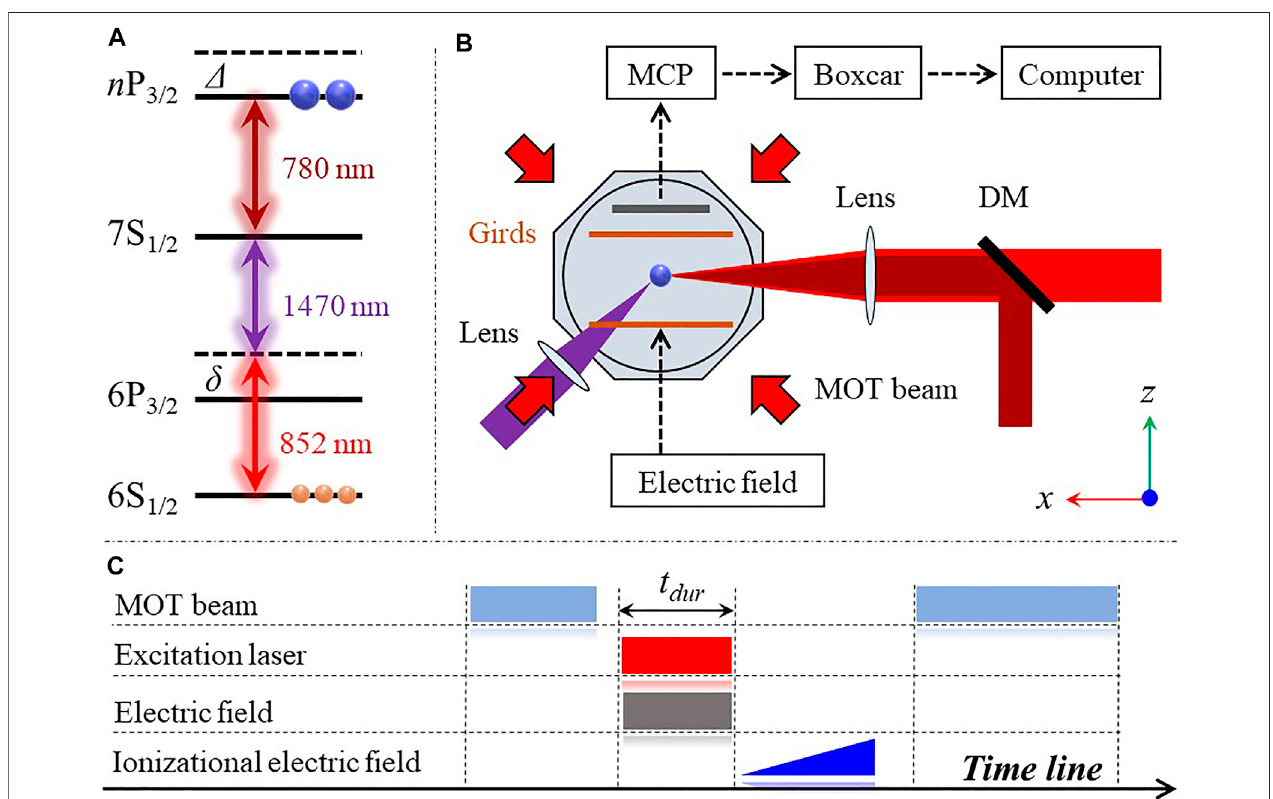
FIGURE2| (color online). (A) Three-photon excitationdiagram ofthe Rydberg state. The fi rst photon from the852 nm (red) laserdrives thelower transition |6S 1/2 〉 → |6P 〉 ,whosefrequencyisbluedetuned δ fromtheintermediatestate.Thesecondphoton,1,470-nm(darkpurple)lasercouplestheintermediatetransitionof|6P 3/2 → |7S 〉 . The third photon, 780-nm (dark red) laser achieves the Rydberg state via the up transition |7S 1/2 Rydbergstateatoms,respectively. (B) Schematicdiagramoftheexperiment.ThreeexcitationlaserscrossthroughtheMOTcenter.TheionsofRydbergatomsare detected with a MCP detector, analyzed with a boxcar, and recorded by a computer. The ramp (DC) electric fi eld is applied to the grids located in the z direction for the fi eld ionization (the manipulation of the Rydberg interaction). Other grids in x − and y − directions are not shown here. (C) Timing sequence. After switching off the MOT beam,theRydbergexcitationpulsewithdurationof6 μ sisswitchedonforpreparingRydbergatoms.DuringtheRydbergexcitation,aweakDCelectric fi eldisappliedto tune the interaction between Rydberg atoms. After the Rydberg excitation, a ramp electric fi eld is applied that is used to selectively ionize the Rydberg atoms. DM: dichroic mirror.